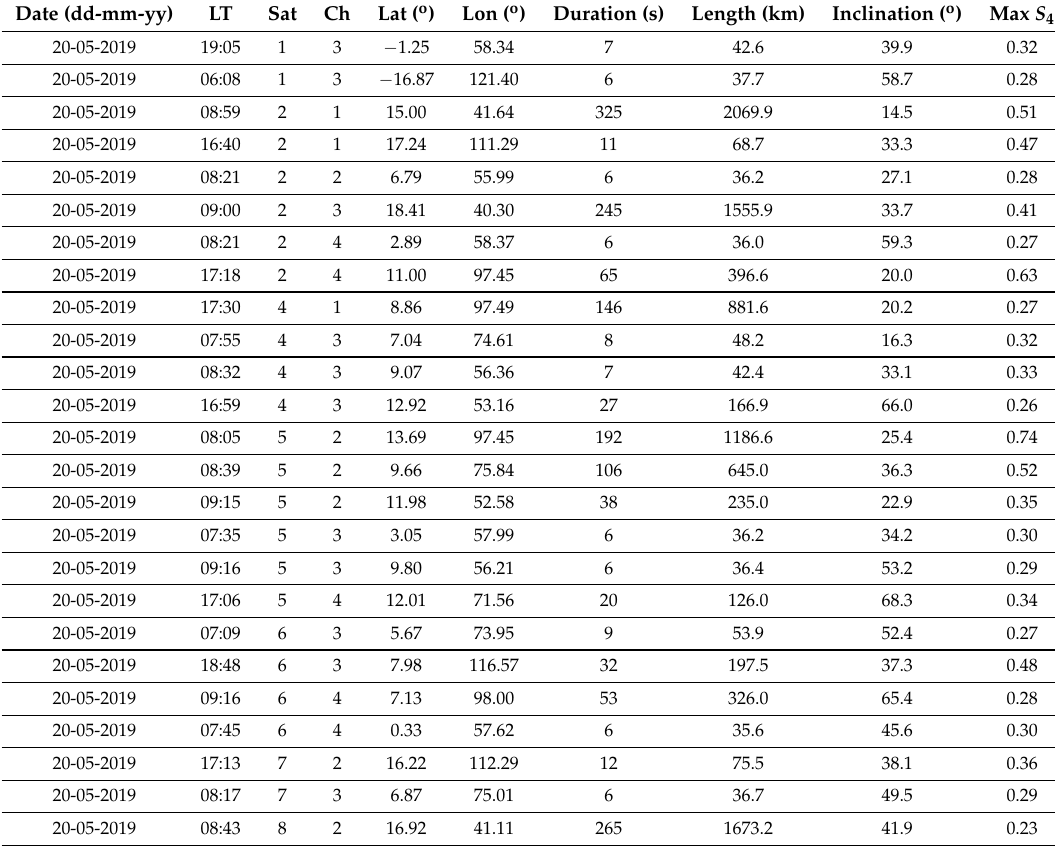
Table 3. Table of peaks with S 4 higher than 0.2 during more than (or equal to) 5 s on 20 May 2019, at Indian Ocean.